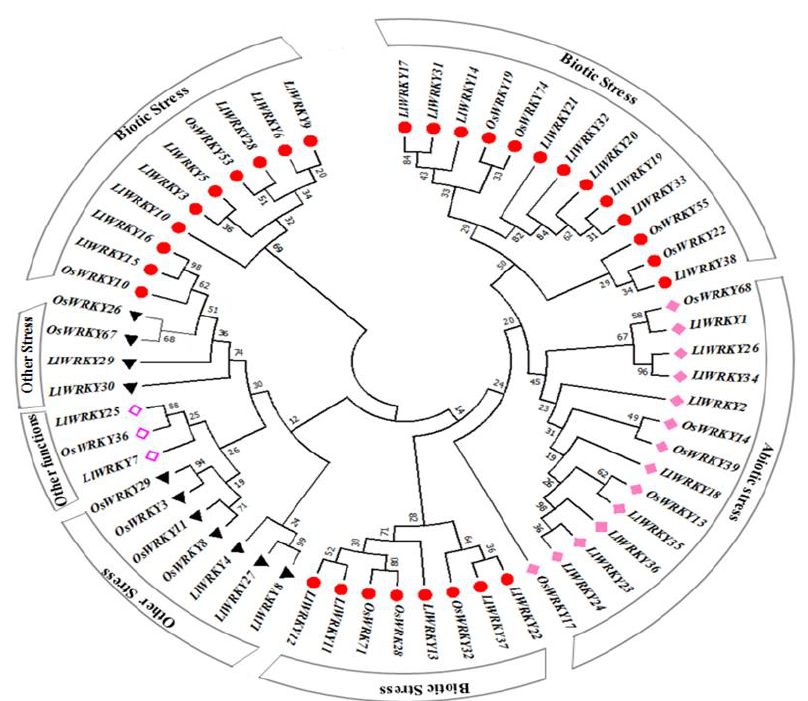
Figure 3. Functional grouping of the annotated LlWRKY proteins based on the homologous gene information regarding biotic stress-responsive genes. The unrooted phylogenetic tree was constructed for Lilium longiflorum and rice proteins to identify homologous gene pairs. Red circles represent the responsive genes to biotic stress; pink squares, black triangles, and magenta squares represent genes responsive to abiotic stress-responsive, other stresses, or possessing other functions, respectively.